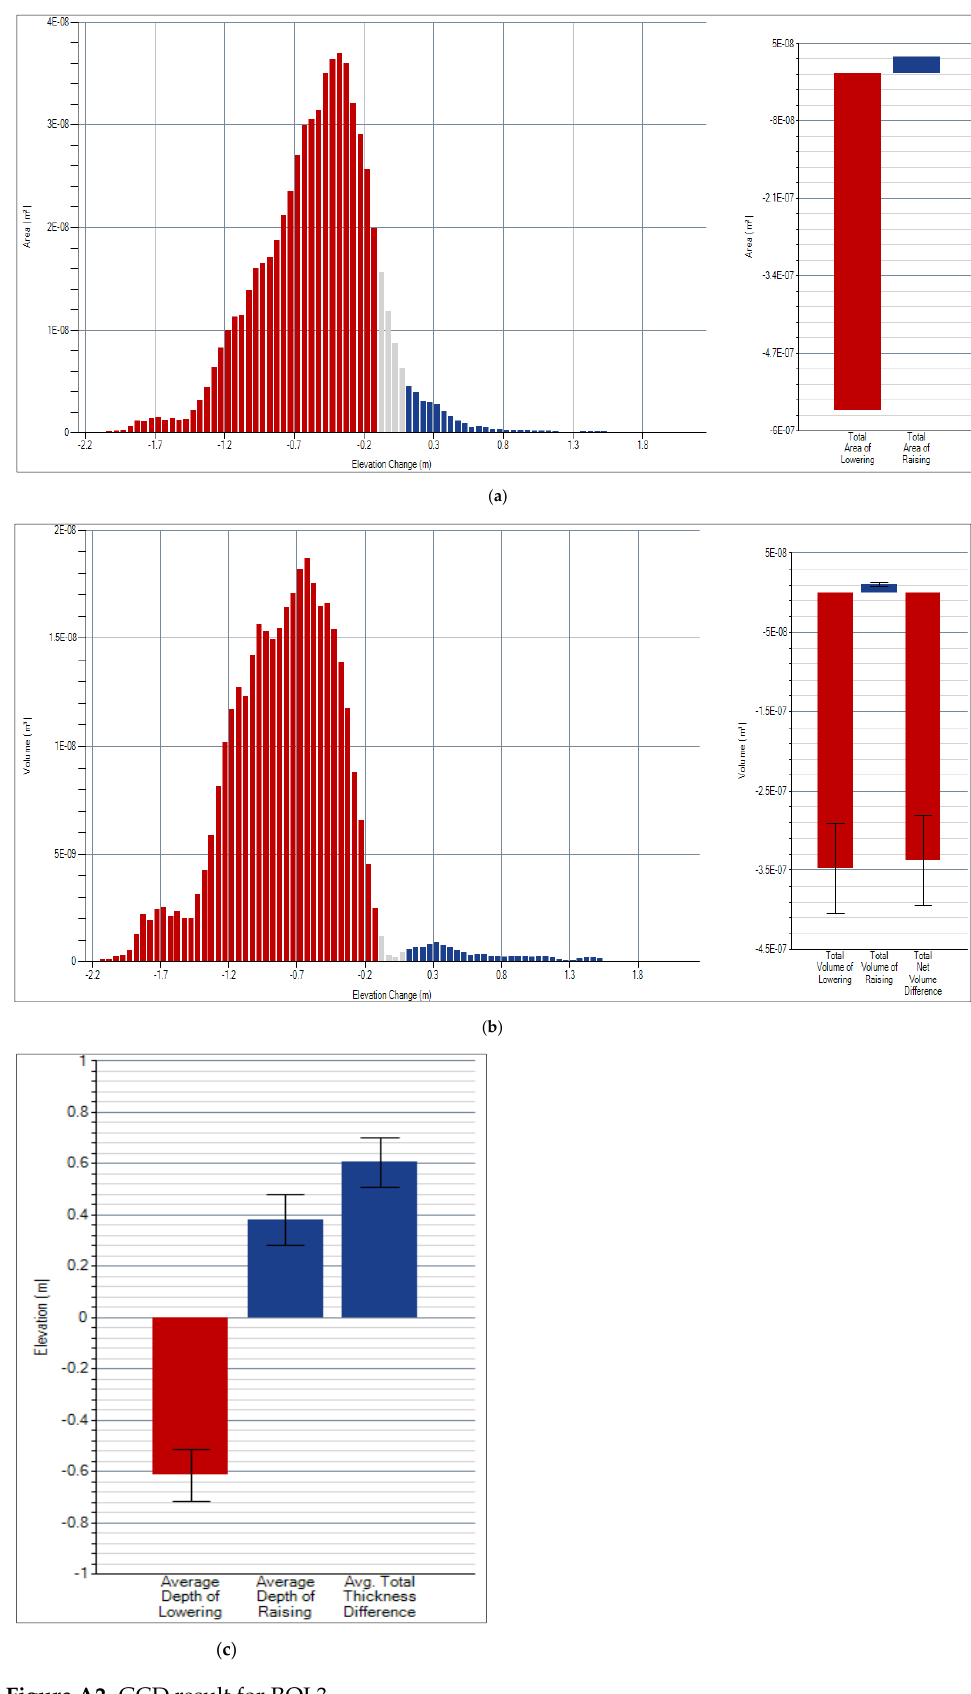
Figure A2. GCD result for ROI3.